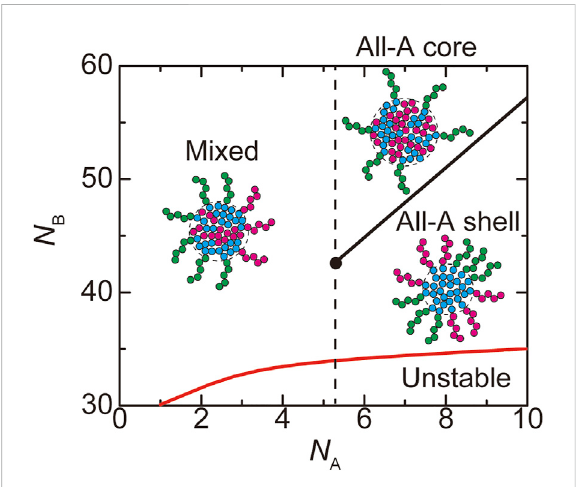
FIGURE 8 The phase diagram of paraspeckles is shown for the number N B of units in the B blocks and the number blocks. The values of parameters used for the calculations are log ( k tx / k 0 ) = − 12.0, N C = 15.0, χ B = 0.5, χ AB =